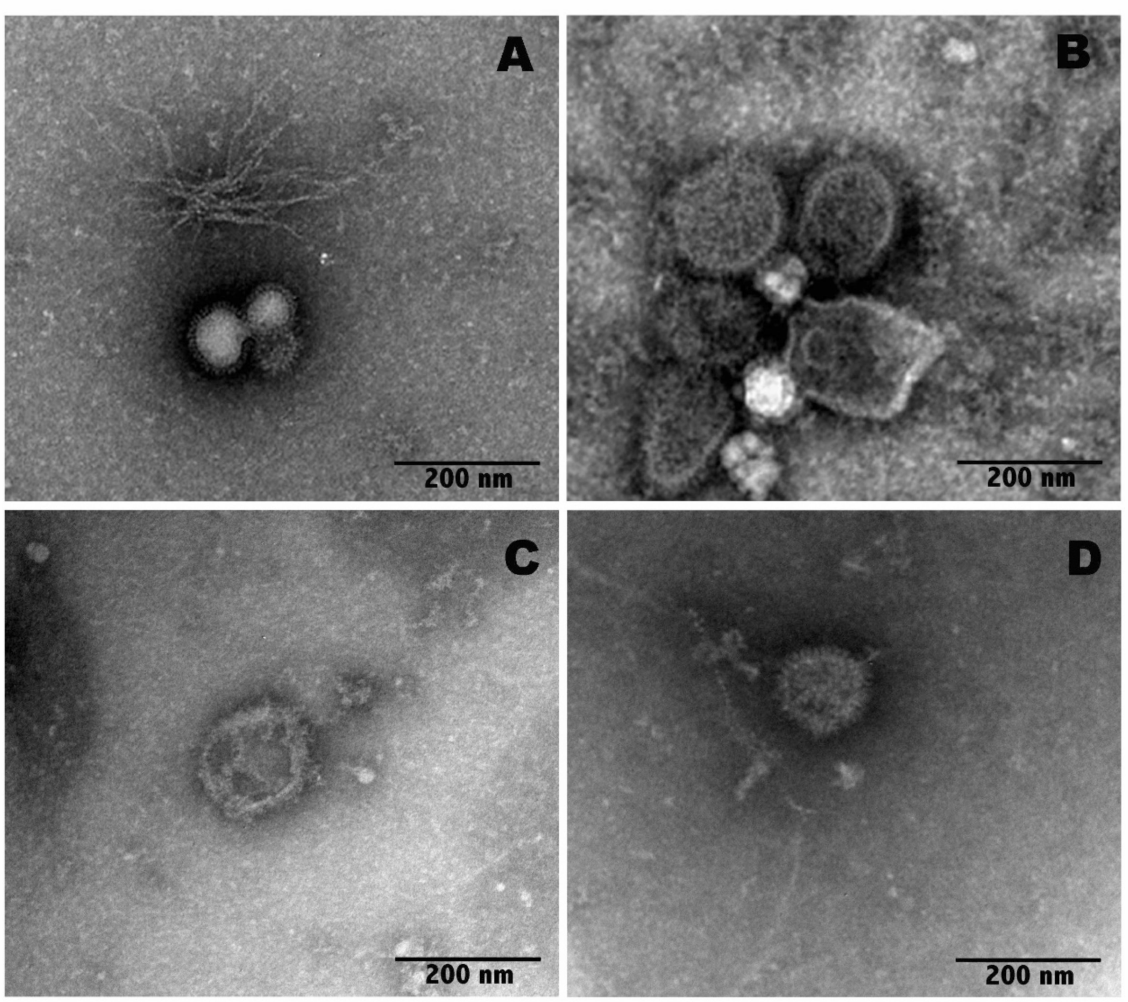
Figure 4. Negative staining of IAV particles. Control virions ( A ), bergamot ( B ), TTO ( C ) or anet- hole ( D ) vapor phases exposed